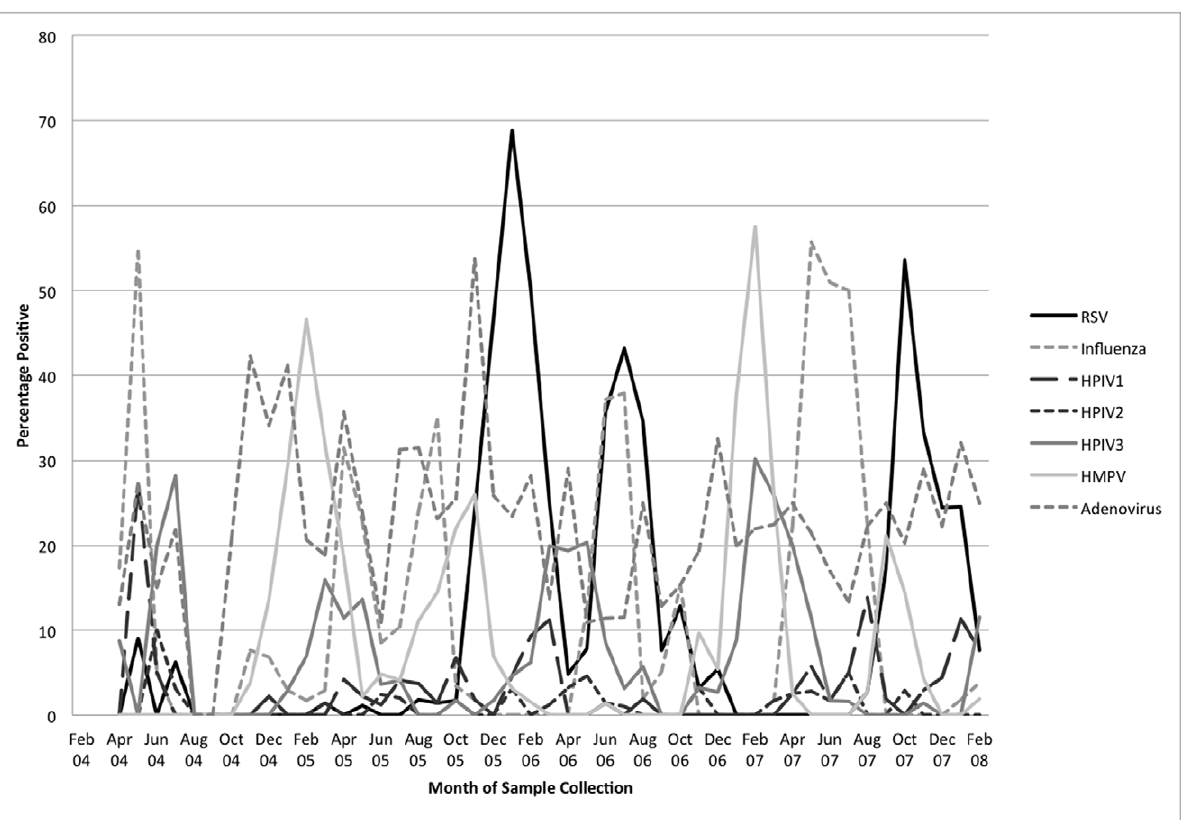
Figure 2. Laboratory detections, by month and year, in children under 5 years with acute lower respiratory infection, Dhaka, 2004—2008.